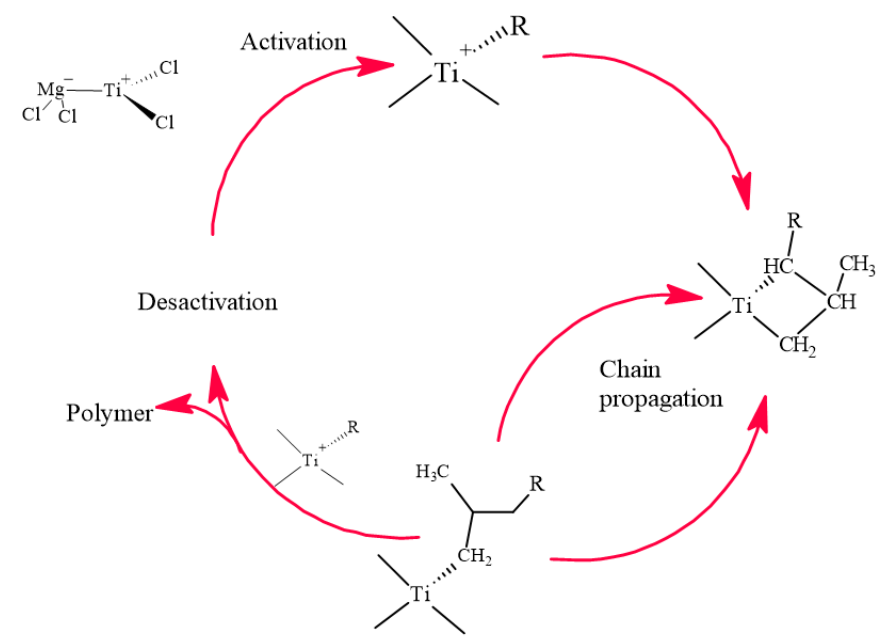
Figure 4. Polymerization reaction.